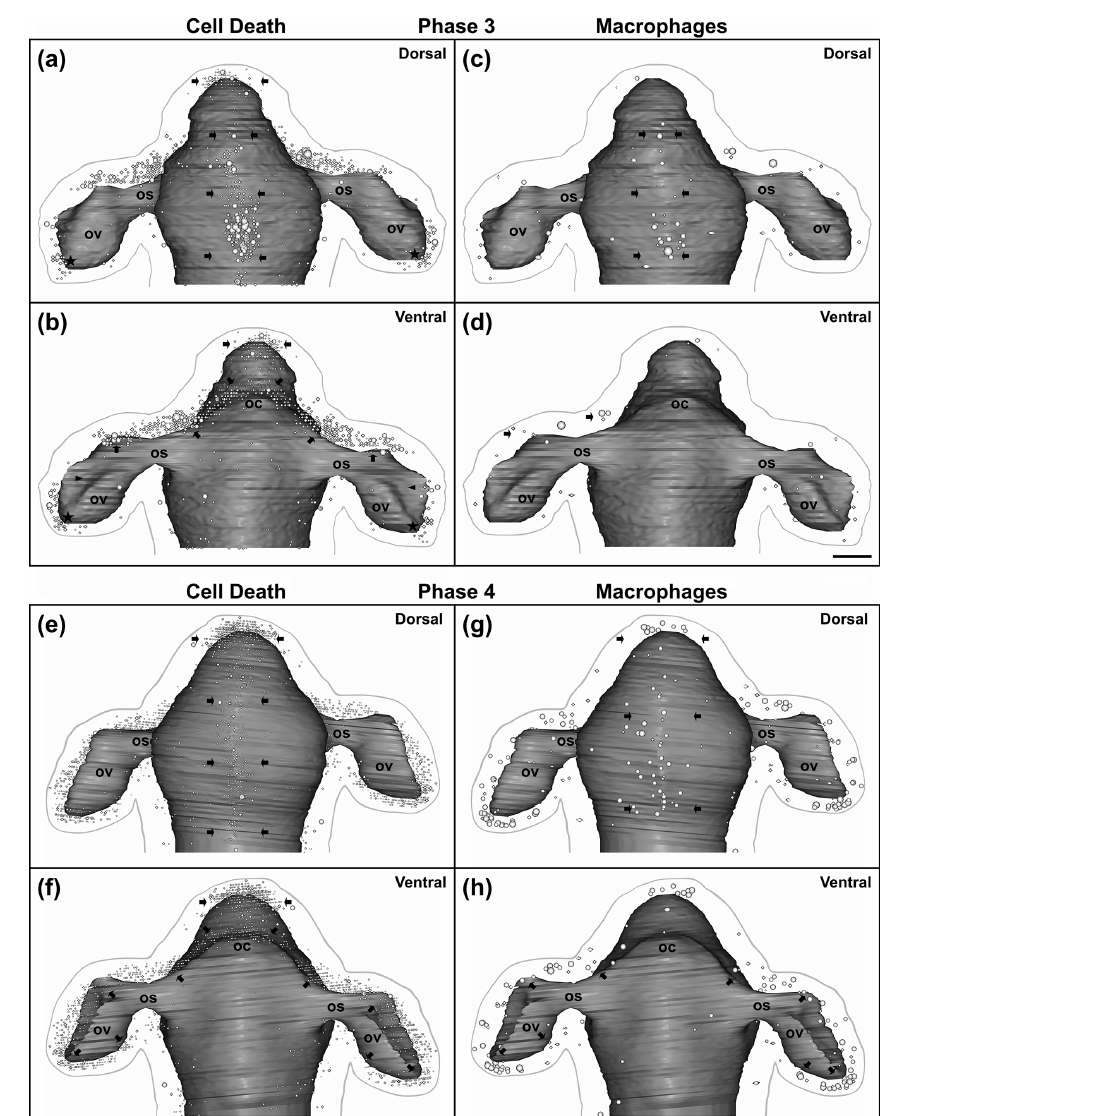
Figure 12. Apoptosis and macrophages in the developing forebrain of Tupaia belangeri . 3-D reconstructions demonstrate the brain ventricle (gray), the pial surface of the brain (light gray contour), and apoptotic bodies (left side: a , b , e , f ) or macrophages (right side: c , d , g , h ) coded as white spheres in each case. (a–d) Embryonic day (E) 15, phase 3 (“onset of invagination of the optic vesicle”). A band of apoptotic cells (arrows) resides in the dorsal midline of the forebrain (a) and proceeds (arrows) to the ventral midline of the forebrain (b) . In the prospective position of the optic chiasm (oc), this band splits to both optic stalks (os) and further extends to the ventrolateral walls of the optic vesicles (ov). Arrowheads, impressions of the optic ventricles due to the initial thickening of the developing retina. (c, d) Groups of macrophages (arrows) are found in the positions of large-scale apoptosis (a, b) . (e–h) E15, phase 4 (“advanced invagination of the optic vesicle”). (e) Numerous fragments of apoptotic cells are present in the dorsal midline of the forebrain (arrows). (f) Again, this apoptotic band continuously extends (arrows) to the ventral pole of the forebrain, to the future position of the optic chiasm and, bilaterally symmetrically, to the optic stalks; and, further, to the invaginating retinal thickenings. In the phase 4 embryo, this band terminates in the future pigment epithelium. (g, h) A band-like formation of macrophages (arrows) largely colocalizes with the maximally extended apoptotic band shown in (e, f) . Scale bars = 100µm. Reproduced from Knabe et al. (2000, Figs. 3, 4). © Springer-Verlag 2000, with kind permission from Springer Science and Business